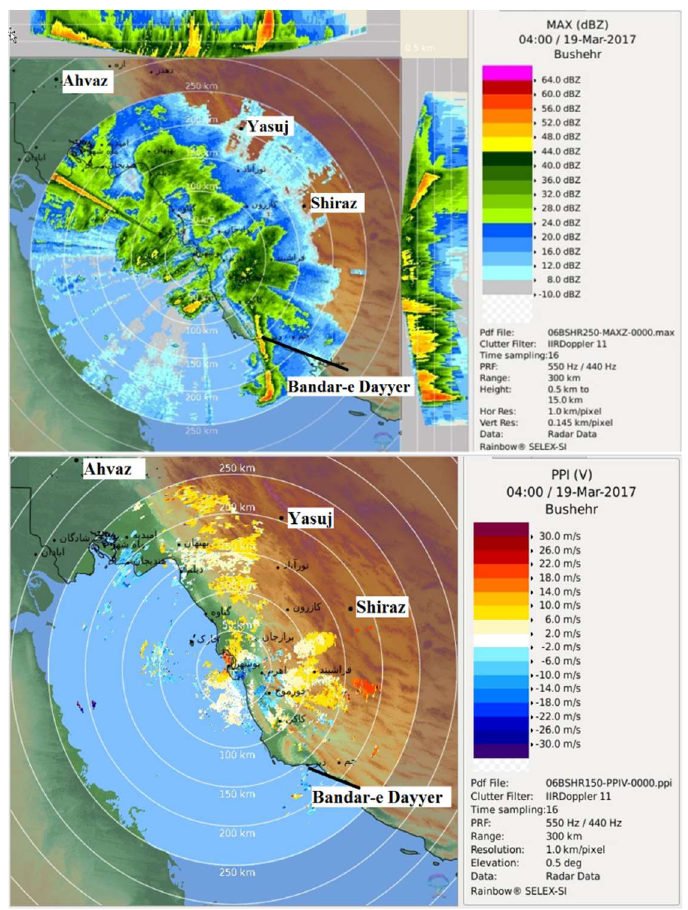
Figure 5. Maximum reflectivity (MAX) ( top panel , in dBZ as presented in the color scale at right of the top panel) and Plan Position Indicator (PPl) ( bottom panel , in m/s as presented in the color scale at right of the bottom panel) from the Bushehr Meteorological Radar on 19 March for 04:00 UTC.